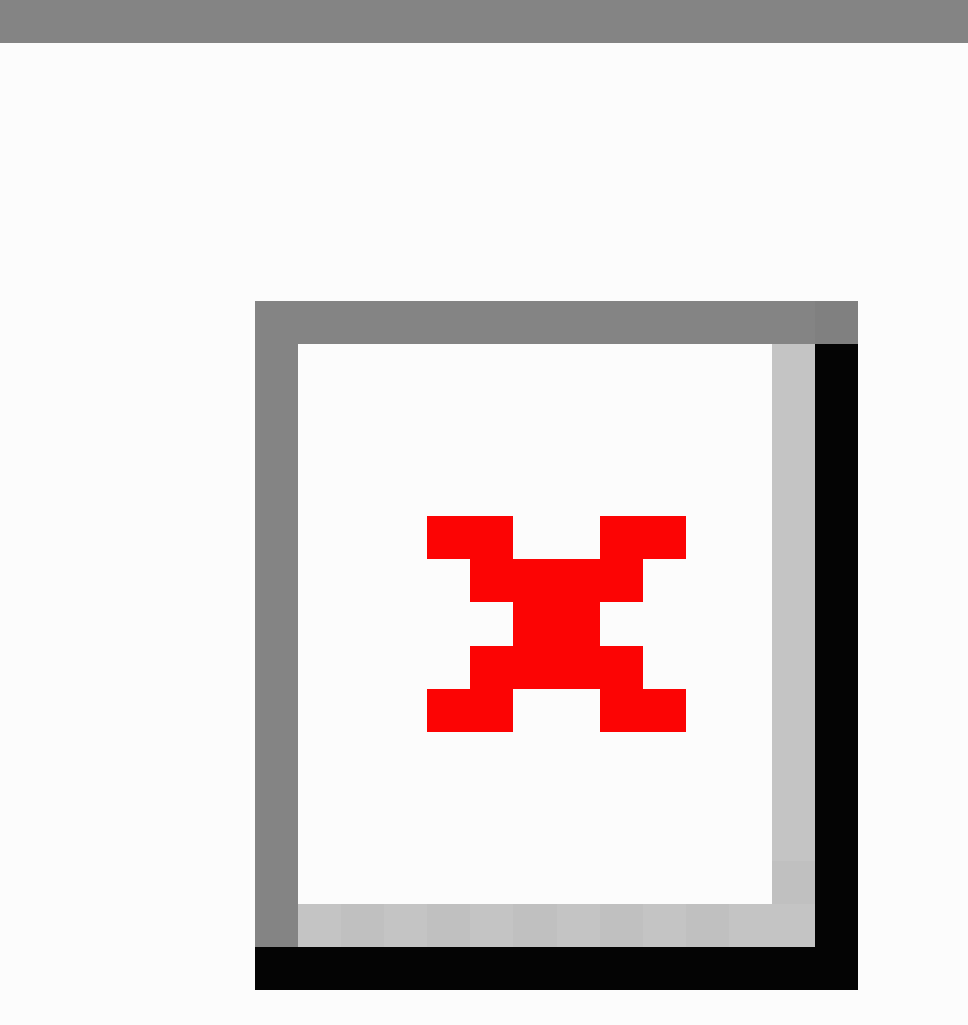
Figure 1. Current age photo (25 years) and future digitally aged photo (65 years) of a female current